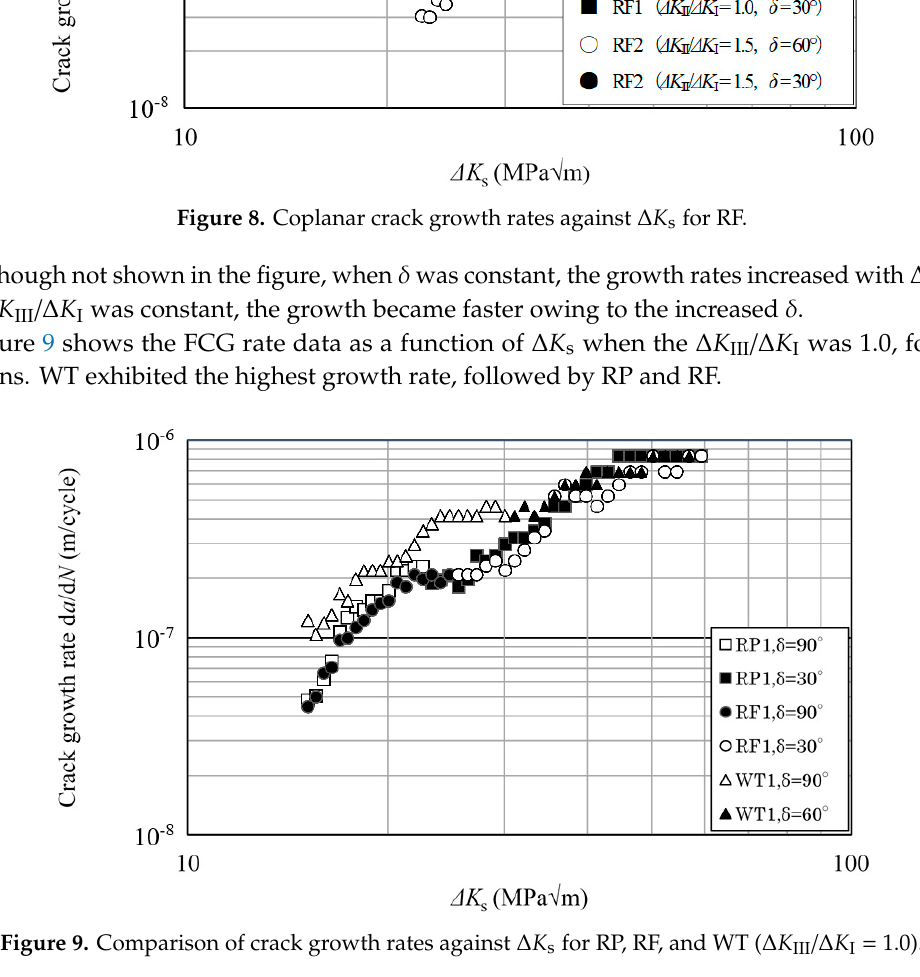
Figure 9. Comparison of crack growth rates against Δ K s for RP, RF, and WT ( Δ K III / Δ K I = 1.0).